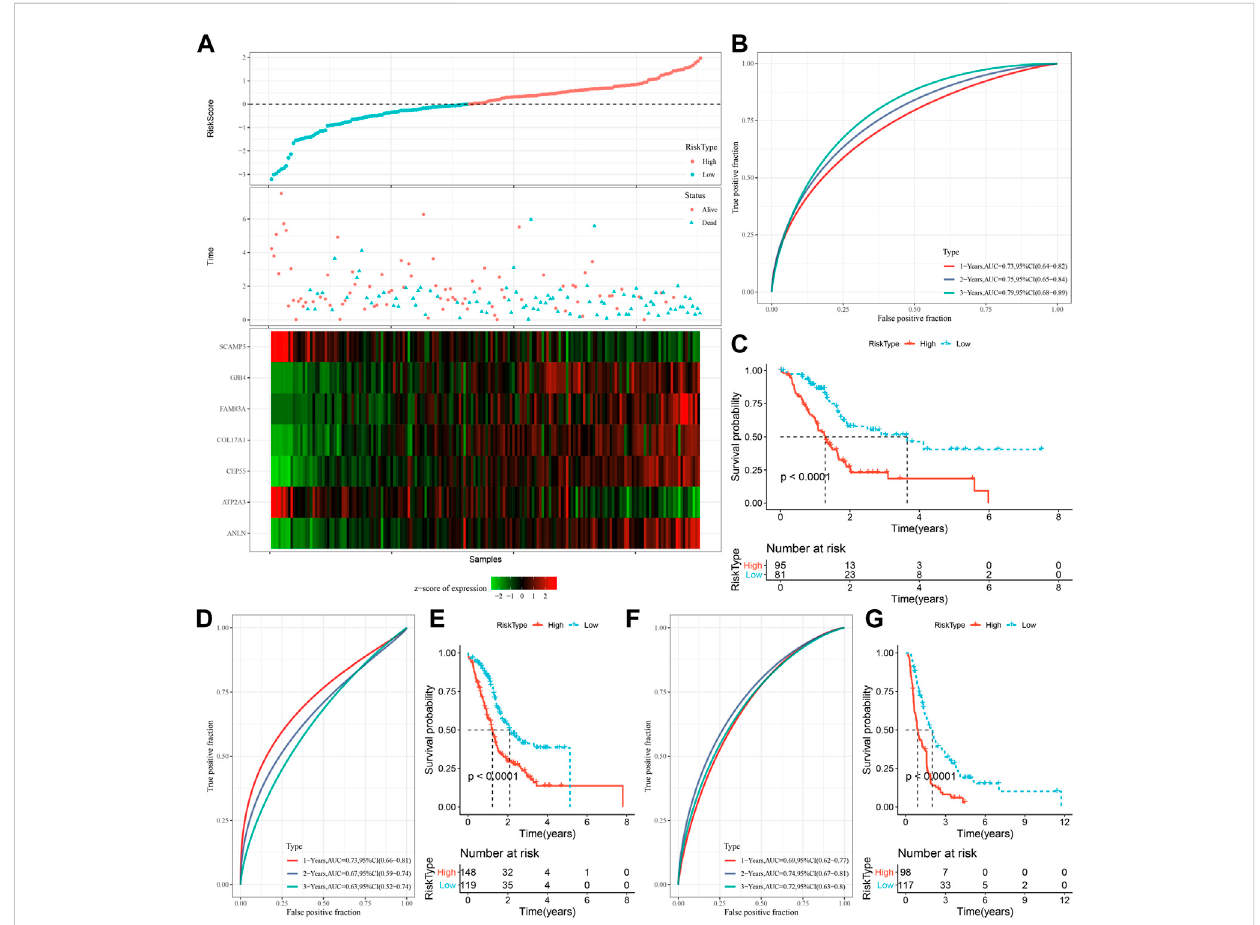
FIGURE 6 Generation and evaluation of risk score models using 7 genes related to oxidative stress. (A) RiskScore, expression of oxidative stress-related prognostic genes and survival time and status in TCGA dataset; (B) RiskScore classi fi cation in TCGA dataset and ROC and AUC curves; (C) Distribution of KM survival curve of RiskScore in TCGA dataset; (D, E) ROC curve and KM survival curve distribution of RiskScore in PACA-AU cohort; (F, G) ROC curves and KM survival curves of RiskScore in the PACA-CA